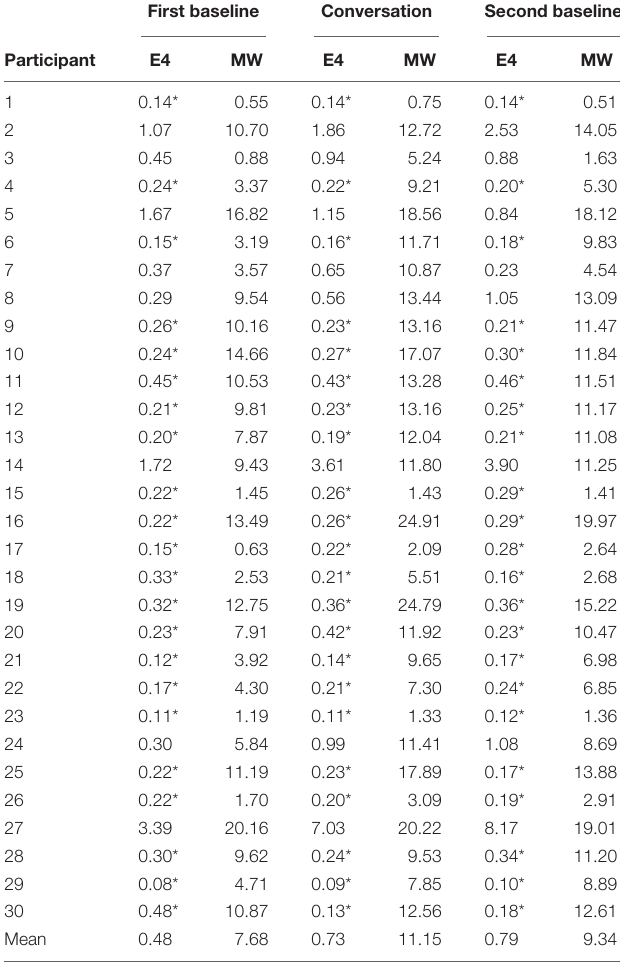
TABLE 6 | Mean skin conductance level in Microsiemens obtained by the E4 and by MW mobile device for each participant, in each of the three segments of the